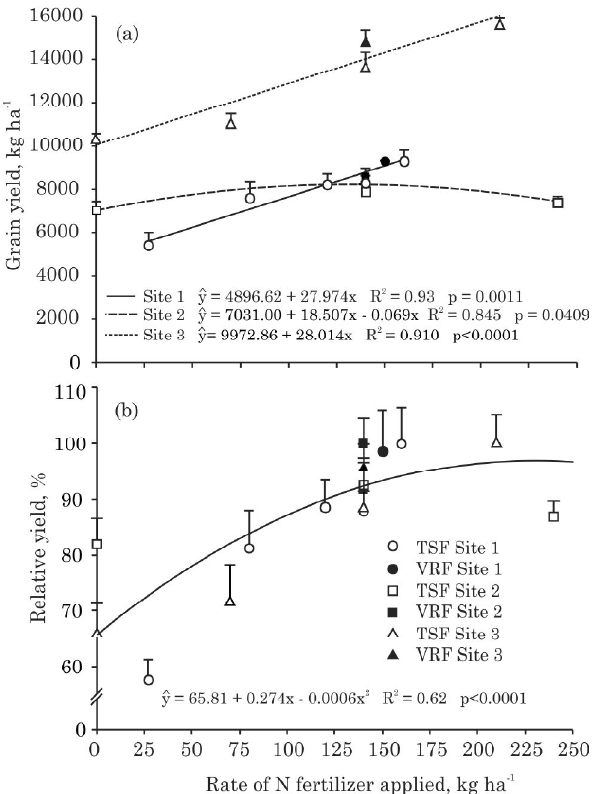
Figure 5. Relationships between N fertilization rates and (a) corn grain yield, and (b) relative corn grain yield at the three investigated